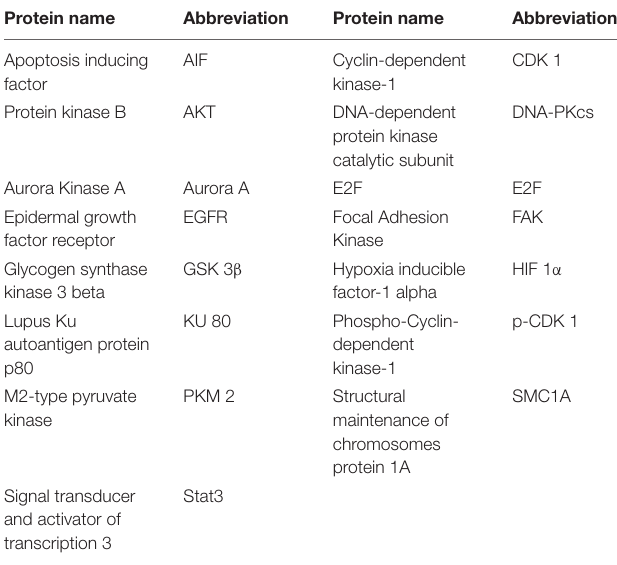
TABLE 1 | List of selected 15 cancer related